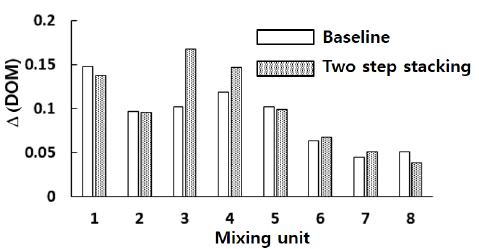
Figure 8. Comparison of DOM increment in each mixing unit for Re = 1.